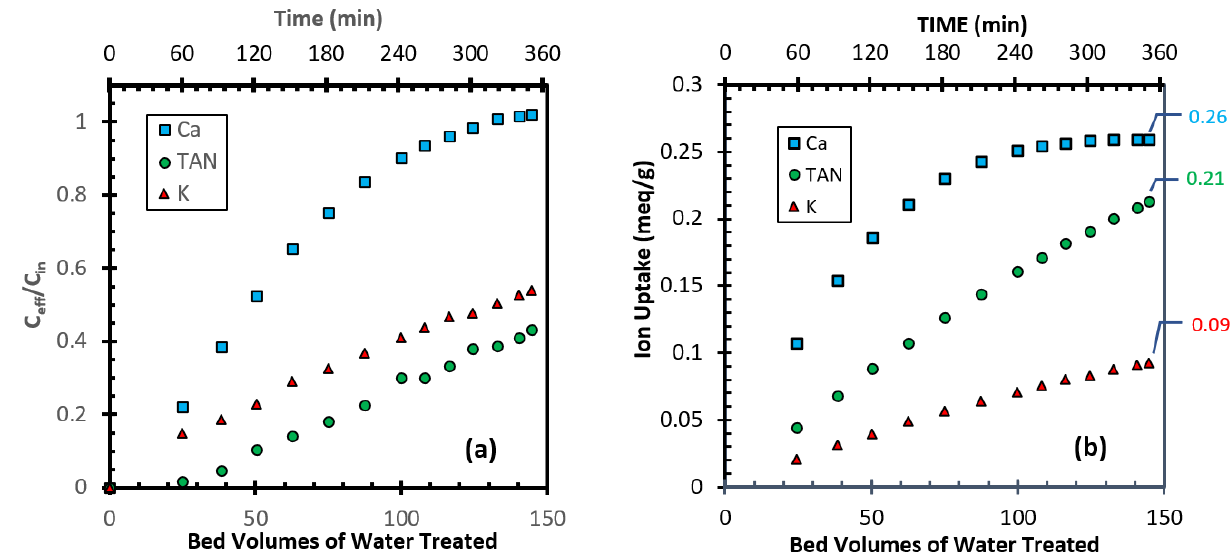
Figure 2. Third 6 h loading cycle with chlorine regeneration (CS3): ( a ) breakthrough; ( b ) ion uptake versus bed volumes of water treated.